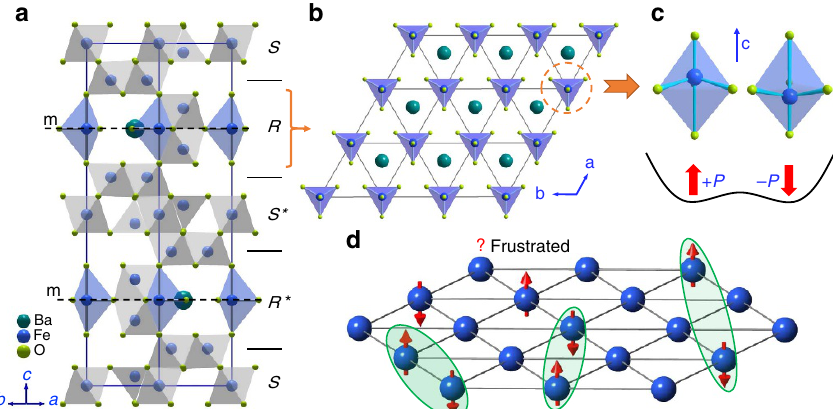
Figure 1 | Uniaxial electric dipoles on a triangular lattice in BaFe 12 O 19 . ( a ) Crystal structure of the M-type hexaferrite BaFe 12 O 19 . It consists of alternate stacks of S and R blocks along the c axis. The asterisk symbols indicate that the corresponding blocks rotate about the c axis by 180 (cid:2) . The Fe 3 þ ions occupy three different sites: octahedral, tetrahedral and bipyramidal (blue) sites. A mirror plane (m) bisects equally the bipyramids in the R/R * blocks. ( b ) The 2D triangular lattice of FeO 5 bipyramids in each R / R * block. ( c ) Illustration of Fe 3 þ off-equator displacements in the FeO 5 bypyramid. The upward or downward displacements at two 4 e sites give rise to small electric dipoles along the c axis. Quantum fluctuations between two 4 e sites persist to T ¼ 0K. ( d ) Frustrated electric dipoles on a triangular lattice. Each site contains an Ising-type electric dipole (red arrow), while the neighbouring interactions favour anti-alignment. Quantum dimers (marked by green ovals) with either short-range or long-range entanglement continue to fluctuate and result in a QEL.